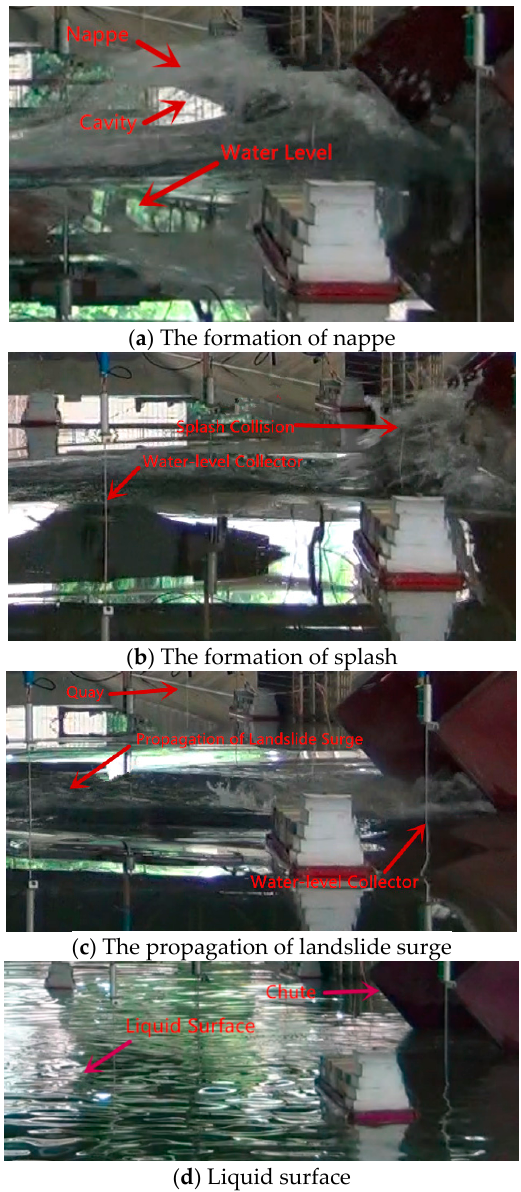
Figure 11. The formation and propagation of a landslide surge.